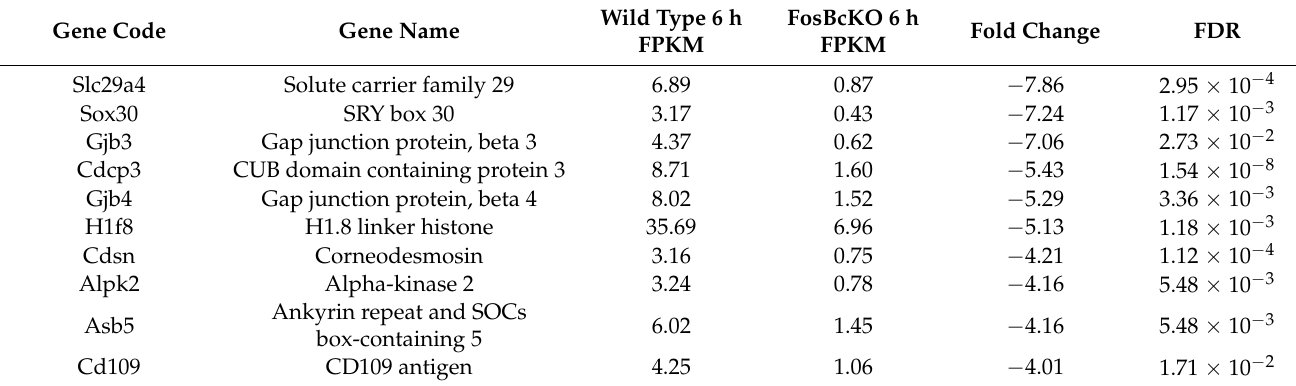
Table 8. Top most downregulated DEGs in FosBcKO LECs at 6 h PCS.